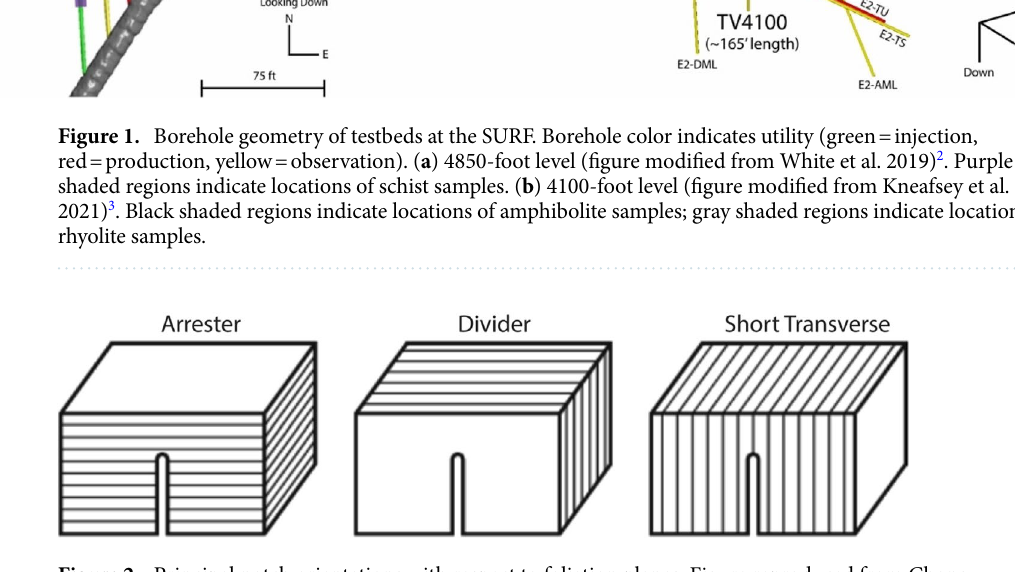
Figure 2. Principal notch orientations with respect to foliation planes. Figure reproduced from Chong et al. 1987 12